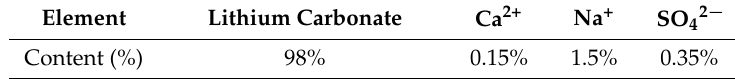
Table 2. The composition of lithium